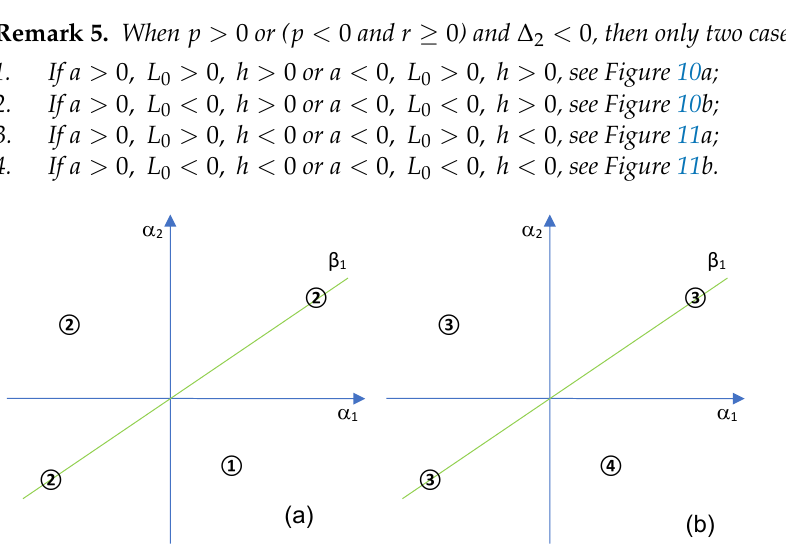
Figure 10. Bifurcation diagrams when p > 0 or ( p < 0 and r > 0): ( a ) a > 0, L 0 > 0, h > 0 or